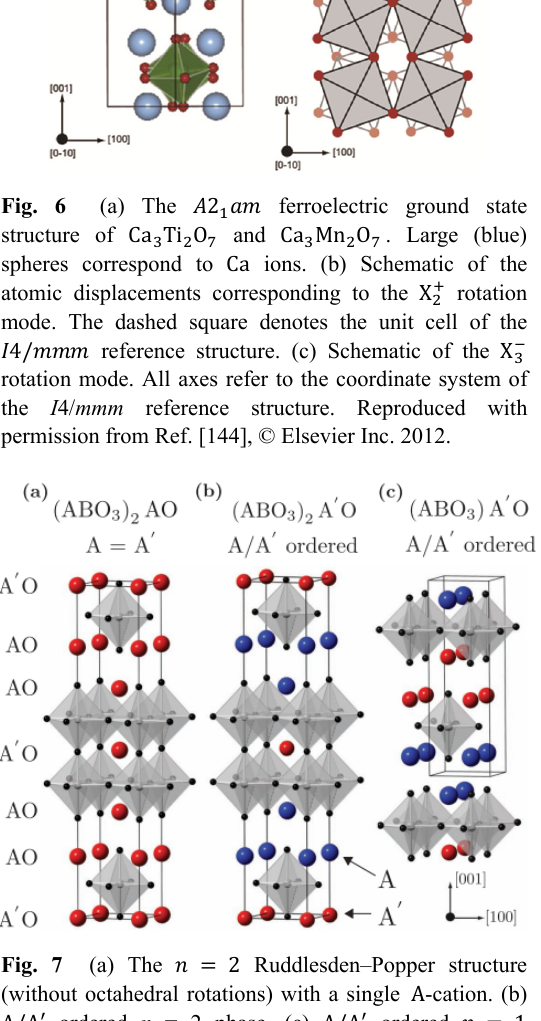
)A′O (cid:2871) and A . B O (cid:2871) (cid:2871) (cid:2870) (cid:2875) BO (cid:2870) (cid:2872)